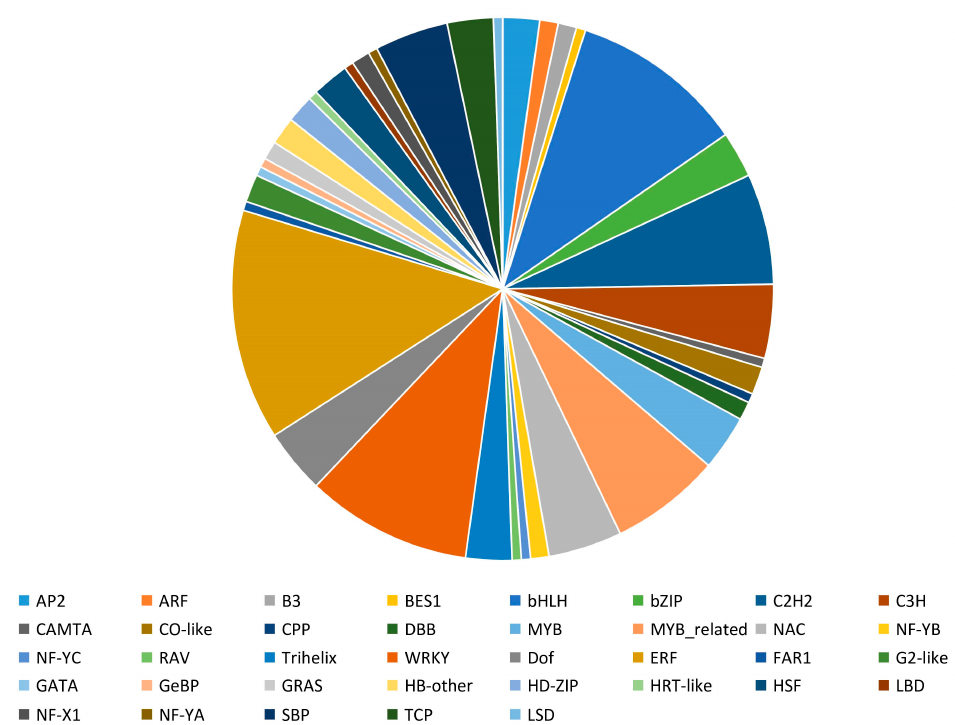
Figure 4. The pie chart shows the number of transcription factors.